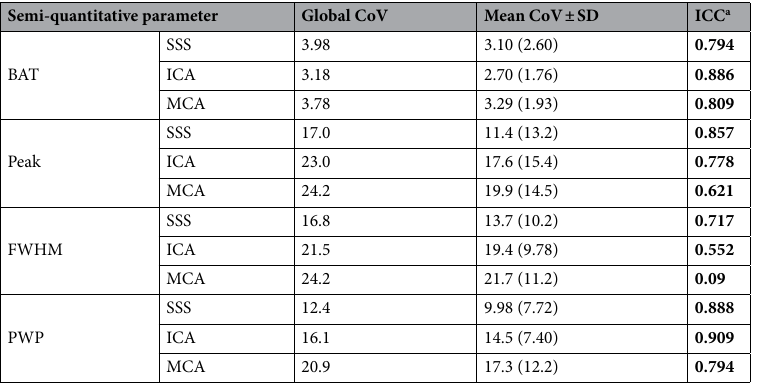
Table 3. Repeatability of semi-quantitative parameters extracted from VOF SSS and arterial (ICA, MCA) VIFs. Significant values are in [bold]. Data shown from 12 patients with NF2-related VS imaged pre-treatment (day 0) and 3 months (day 90) following treatment with bevacizumab (Avastin ©). Individual patient level coefficient of variation (CoV) values reported alongside mean (+ /− S.D) and global CoV. a Average measures ICC estimates are reported based on an absolute-agreement, 2-way mixed-effects model. BAT Bolus arrival time, ICA Internal carotid artery, ICC Average measures intraclass correlation coefficient, MCA Middle cerebral artery, PWP Bolus peak∙FWHM product, SSS Superior sagittal sinus, VIF Vascular input function, VOF Vascular output